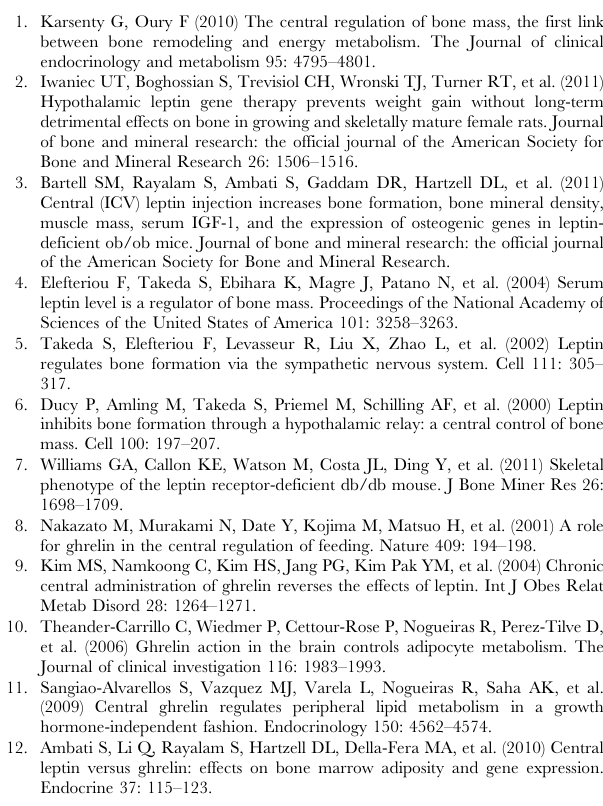
Figure S2 Effect of chronic ICV ghrelin infusion on the spine trabecular bone phenotype. (A) Trabecular bone volume expressed as percentage of total tissue volume (BV/TV). (B) Trabecular thickness (Tb.Th). (C) Trabecular number (Tb.N). (D) Trabecular separation (Tb.Sp). (E) Trabecular pattern factor (Tb.Pf). (F) Structure model index (SMI). (G) Trabecular volumetric BMD. (H) Representative microCT images of the lumbar spine. Three groups of rats (4–6 per group) were infused for 21 days with saline or ghrelin (1.5 m g/day). Rats infused with ghrelin were ad lib -fed or pair-fed (to saline-infused rats). * P , 0.05; { P , 0.1. Data are presented as the mean 6 SEM. (TIF) Figure S3 Effect of chronic ICV ghrelin infusion on the tibia cortical bone phenotype. (A) Total cross-sectional area inside the periosteal envelope (Tt.Ar). (B) Cortical bone area (Ct.Ar). (C) Cortical area fraction (Ct.Ar/Tt.Ar). (D) Medullary area (Ma.Ar). (E) Cortical thickness (Ct.Th). (F) Cortical porosity (Ct.Po). (G) Periosteal perimeter (Ps.Pm). (H) Endocortical perimeter (Ec.Pm). (I) Representative microCT images of the mid-diaphysis tibia. Three groups of rats (4–6 per group) were infused for 21 days with saline or ghrelin (1.5 m g/day). Rats infused with ghrelin were ad lib -fed or pair-fed (to saline-infused rats). * P , 0.05; { P , 0.1. Data are presented as the mean 6 SEM.